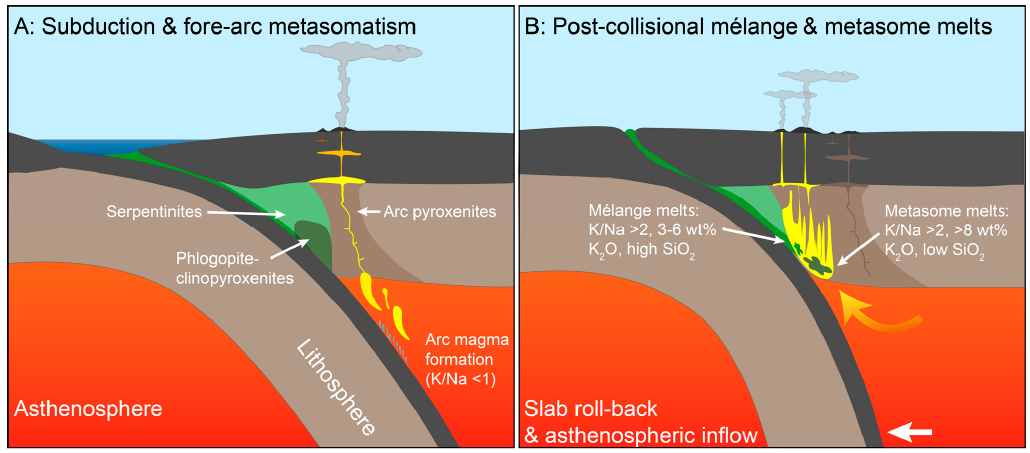
Figure 6. Model for the genesis of post-collisional UP magmatism. ( A ) Fore-arc mantle is metasomatized by melts of subducting sedimentary rocks; melts have K / Na ratios > 2 and react with depleted mantle to form phlogopite clinopyroxenites, leaving a K-depleted residuum that contributes at deeper levels to arc magmas with low K / Na ratios of < 1. ( B ) After slab-rollback (and possibly during continental collision), upwelling asthenosphere introduces heat and melts the metasomes and m é langes. These second-stage magmas are ultrapotassic in composition (K / Na > 2, K 2 O 3 wt%–6 wt% from crust, and m é langes and up to > 8 wt% for metasome melts).